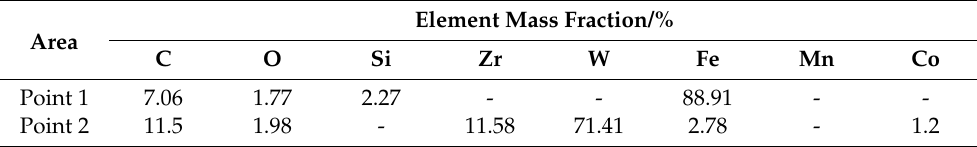
Figure 13. Morphology of flank wear for WC-Co-Zr cutters, ( a ) FC5-1, ( b ) FC5-2, ( c ) FC5-3, and ( d ) FC5-4. Table 2. The EDS results of Points 1 and 2 in Figure 12.